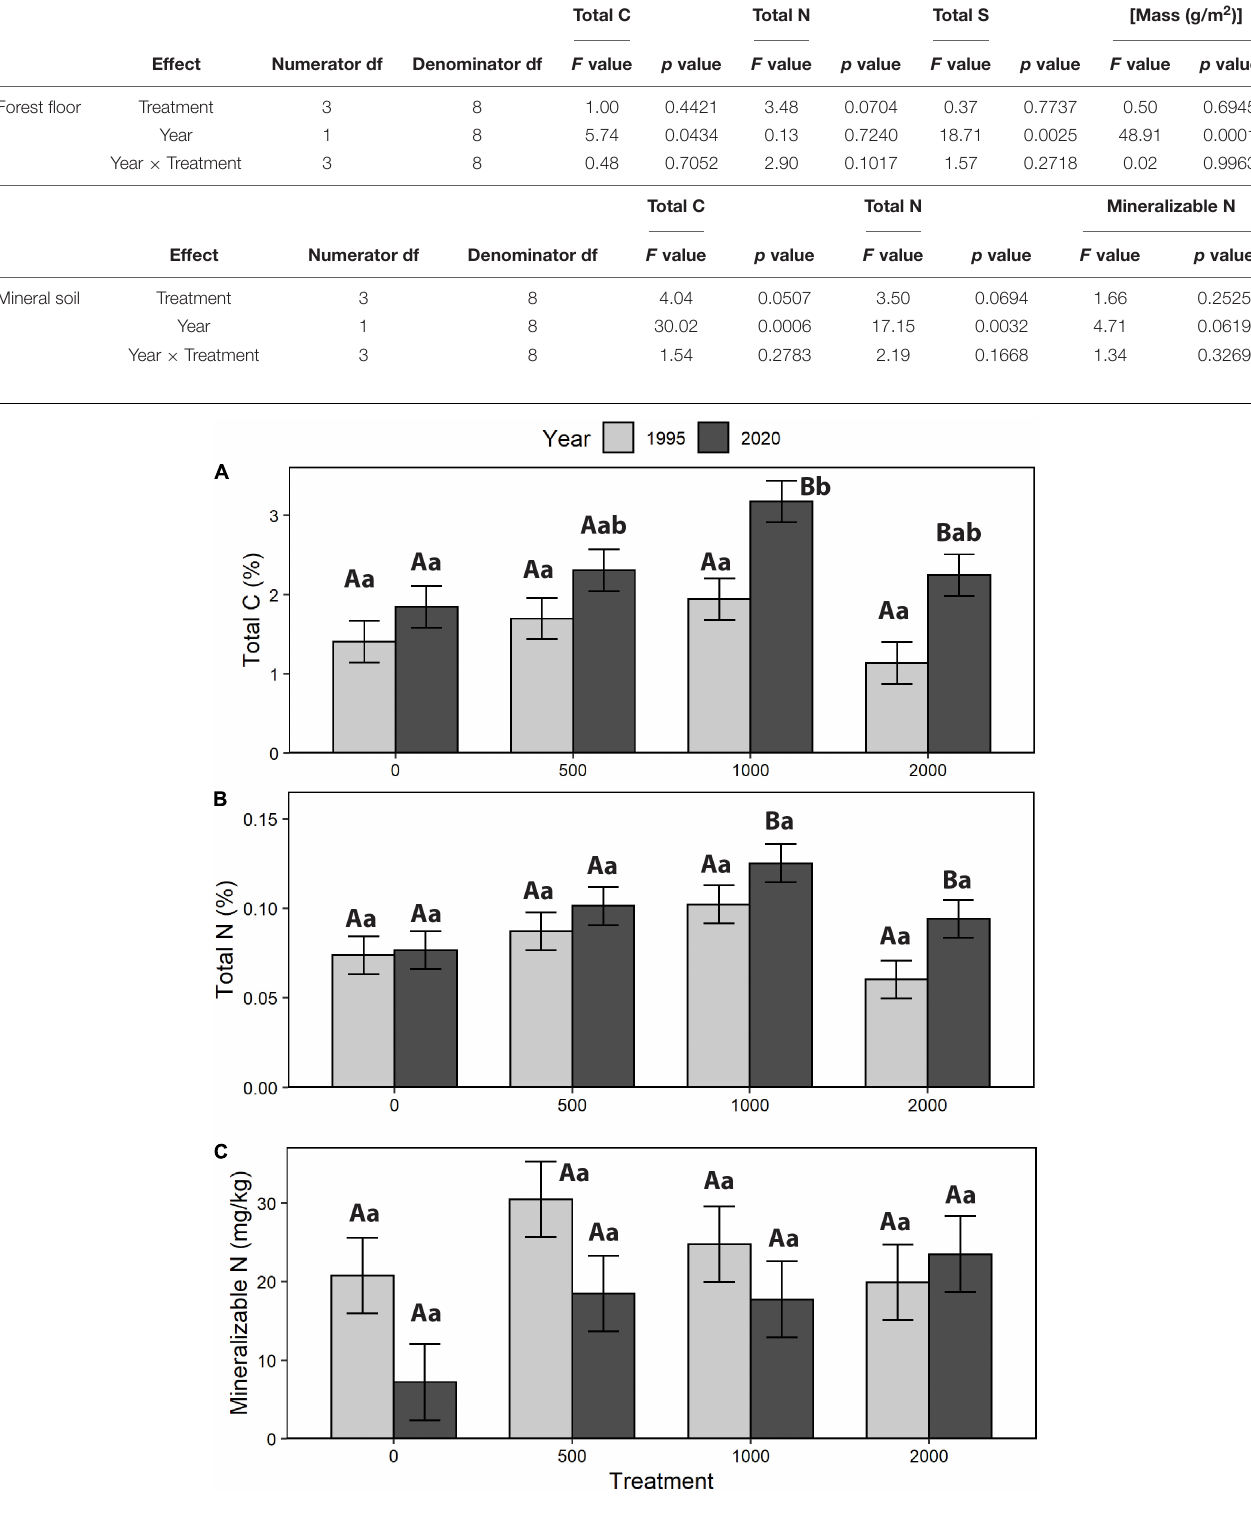
Frontiers in Forests and Global Change |